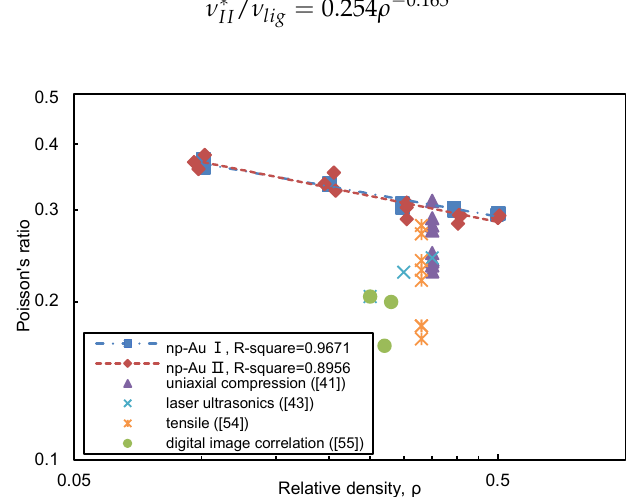
Figure 6. Variation of Poisson’s ratio of nanoporous gold with relative density. Simulation results from this study for the two nanoporous gold samples are denoted as “np-Au I” and “np-Au II”. Experiment results are also compared